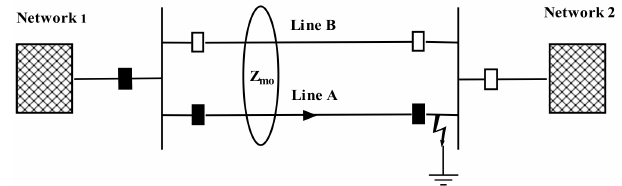
Figure 7. Parallel circuit disconnected (one or both ends isolated).